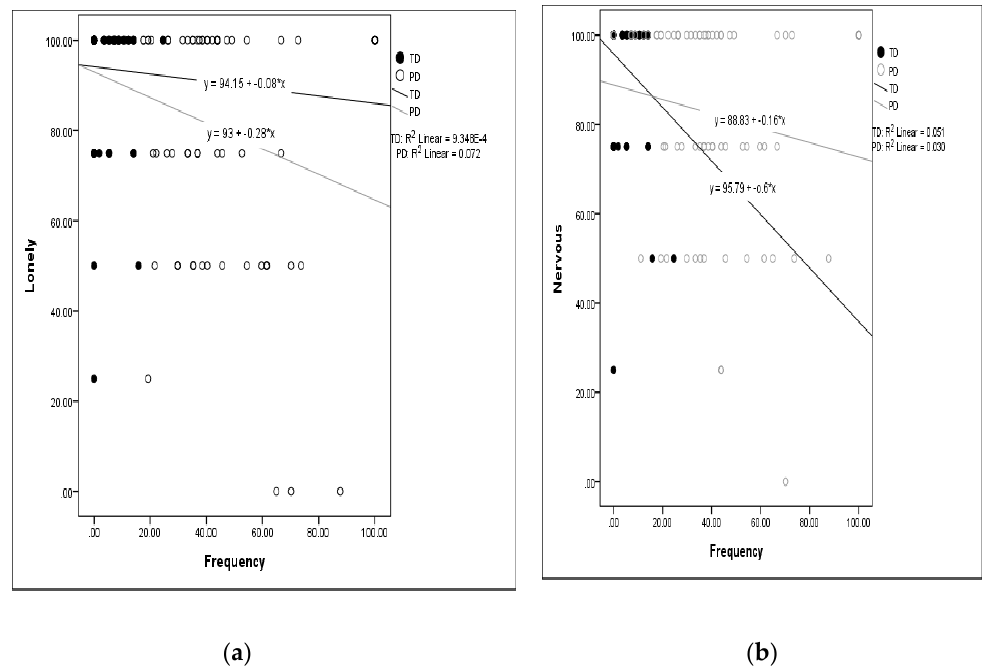
Figure 3. The scatter plots of correlations between ( a ) lonely and frequency; ( b ) nervous and frequency at the fourth time point. Table 3. Correlation coefficients between mental health problems measured by the Child Health Questionnaire (CHQ) and participation independence and frequency of attendance. T4 Lonely T4 Upset T4 Nervous Z-Score